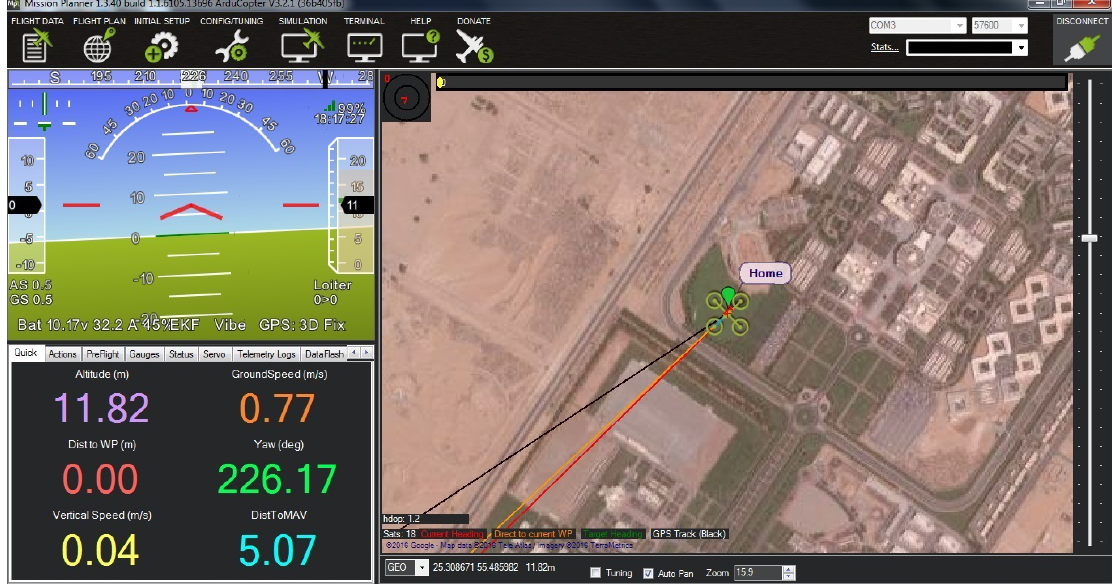
Figure 5. Mission Planner screenshot during